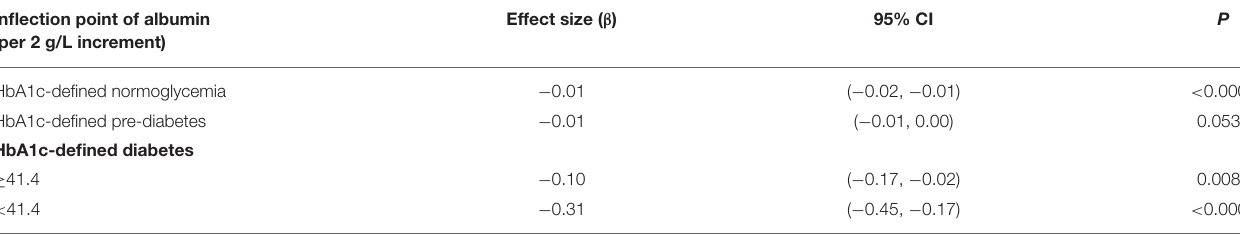
TABLE 4 | Analysis of the threshold effect of albumin on HbA1c using piecewise linear regression. Inflection point of albumin (per 2 g/L increment)